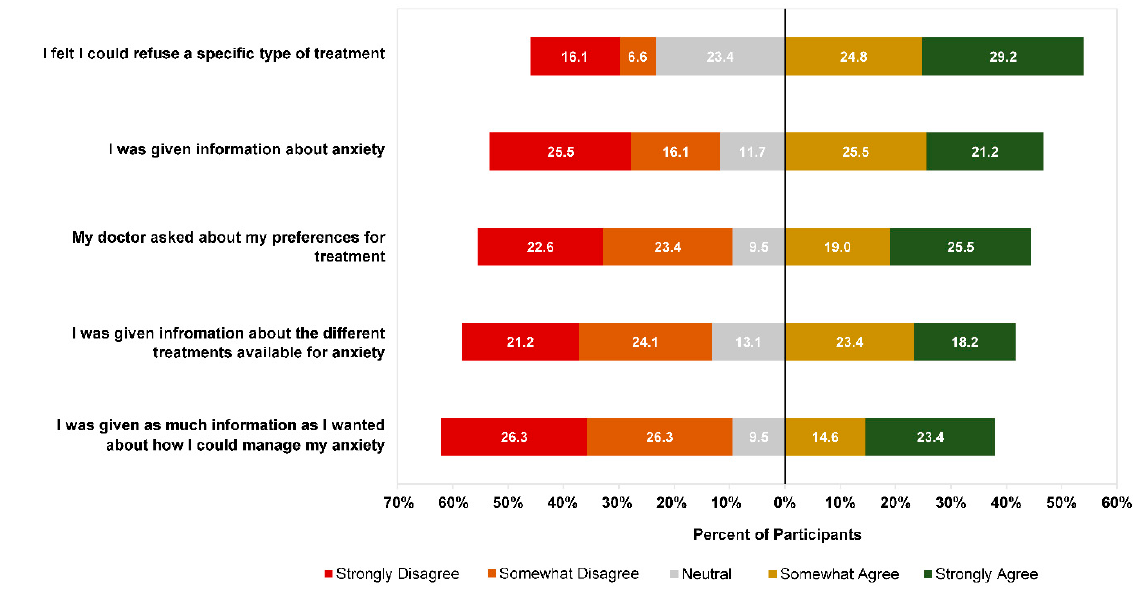
Figure 2. Participant ratings (n = 137) of GP treatment approach at first experience of seeking help for anxiety. Data missing for one participant.